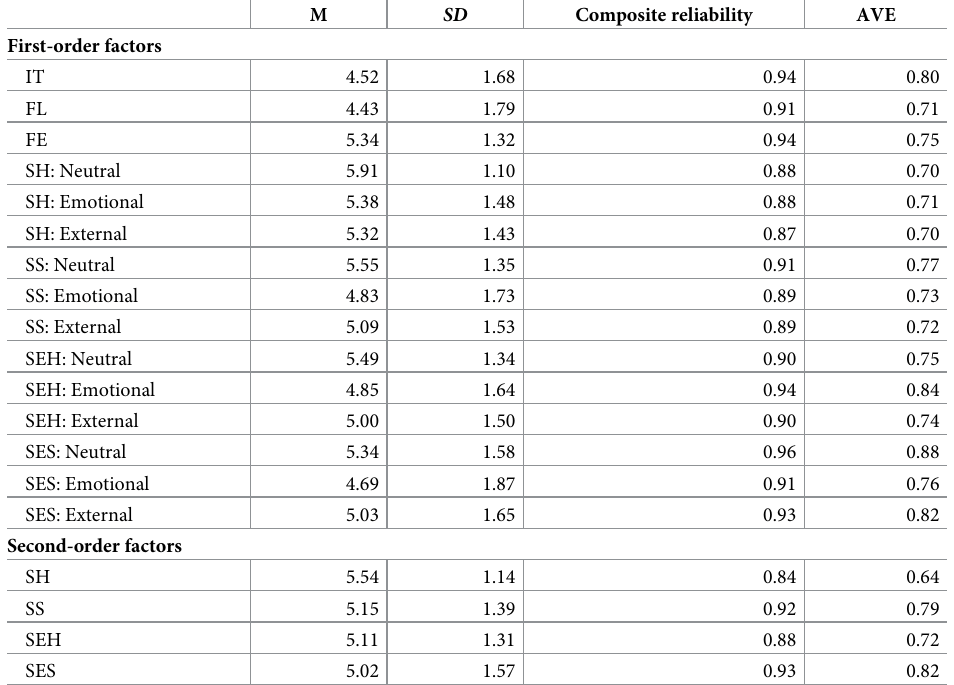
IT: Internal trust, FL: Food legalizing, FE: Food enjoyment, SH: Sensitivity to physiological signals of hunger, SS: Sensitivity to physiological signals of satiation, SEH: Self-efficacy in using physiological signals of hunger, SES: Self- efficacy in using physiological signals of satiation, AVE: Average Variance Extracted.